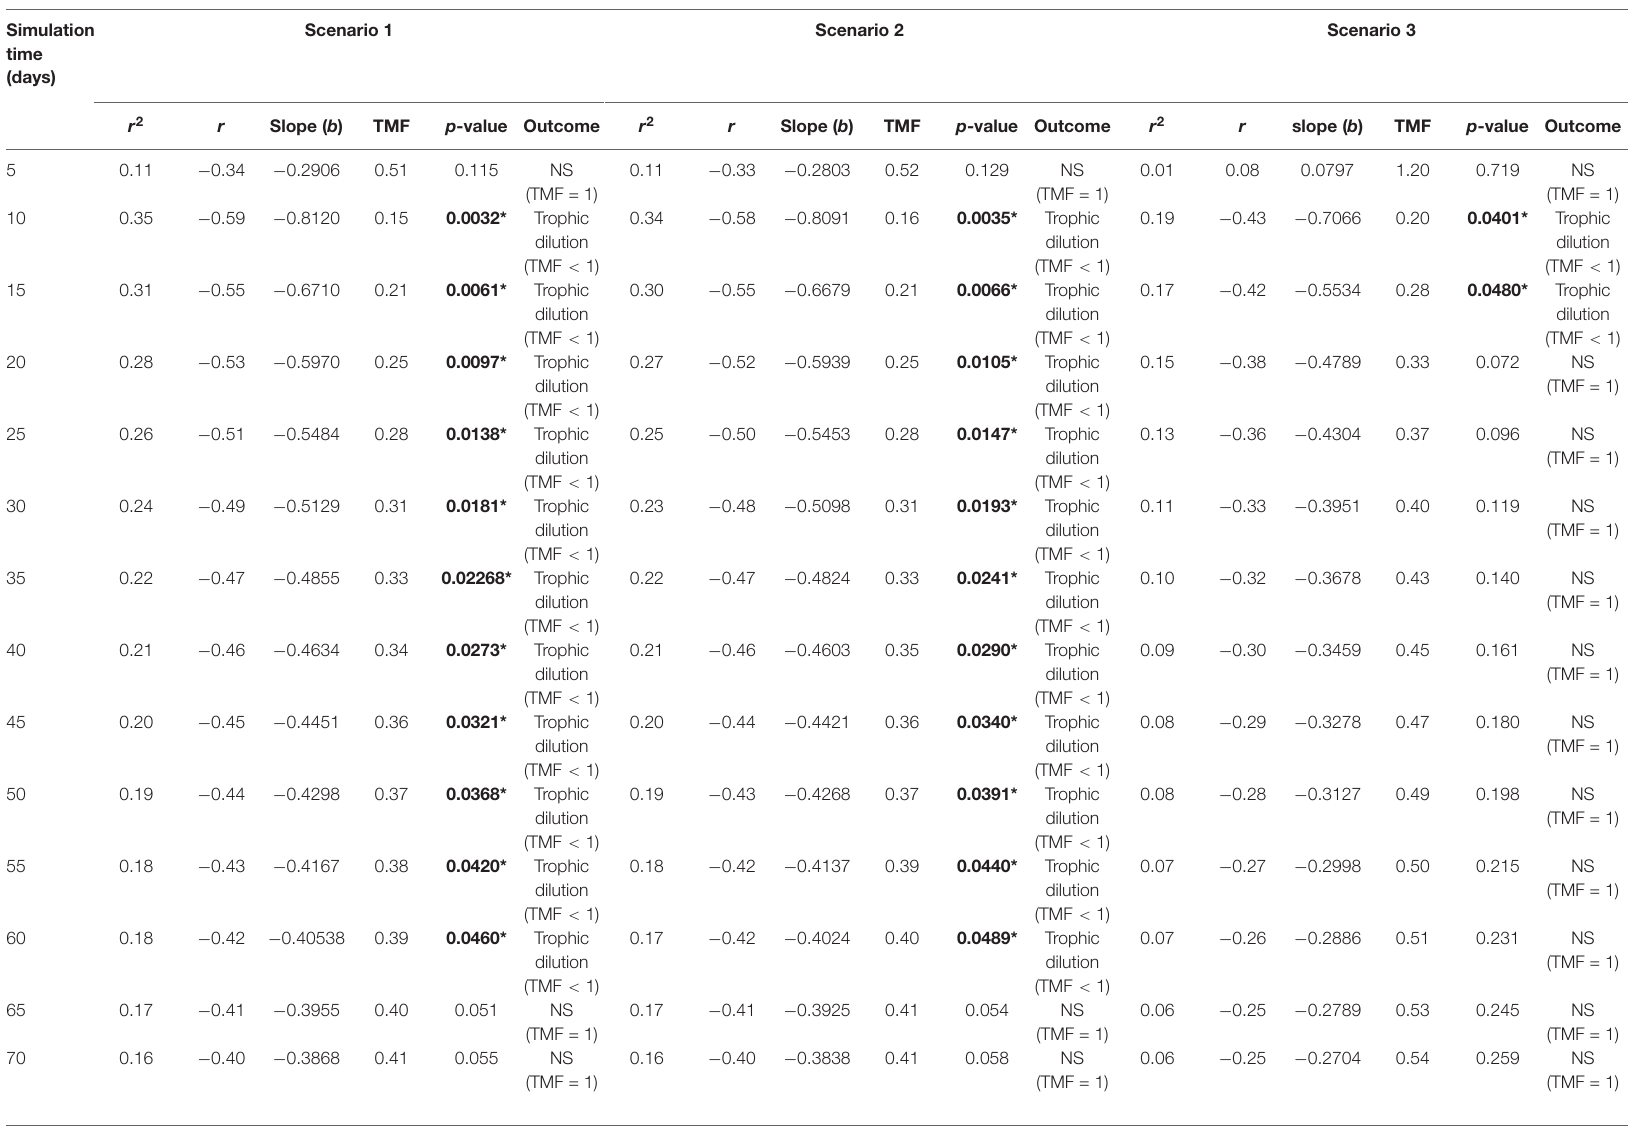
TABLE 1 | Apparent trophic magnification factors (TMF) and regression statistics for the linear regression models of the log of microplastic (MP) concentrations versus trophic level, representing the conditions under low (scenario 1: seawater [0.003 g/L] and sediment [0.266 g/kg dw]), moderate (scenario 2: seawater [0.010 g/L], and sediment [0.886 g/kg dw]) and high (scenario 3: seawater [0.040 g/L] and sediment [111 g/kg dw]) concentrations scenarios (see Supplementary Table S2 ) from 5 to 70 days of simulation time, with a zooplankton elimination rate ( k E ) of